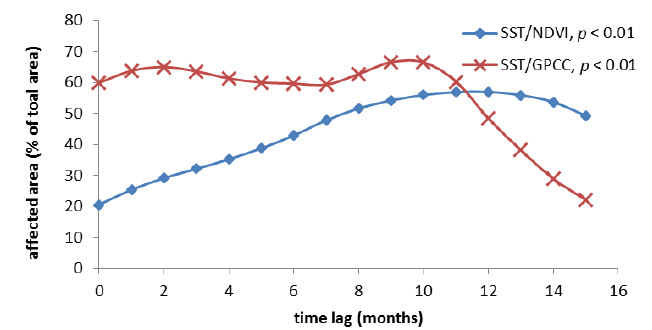
Figure 7. The dependency of total affected area on lag length (in months) for the linear relation between monthly NDVI3g and Nino 3.4 SST data (blue) and monthly GPCC precipitation and Nino 3.4 SST data (red).